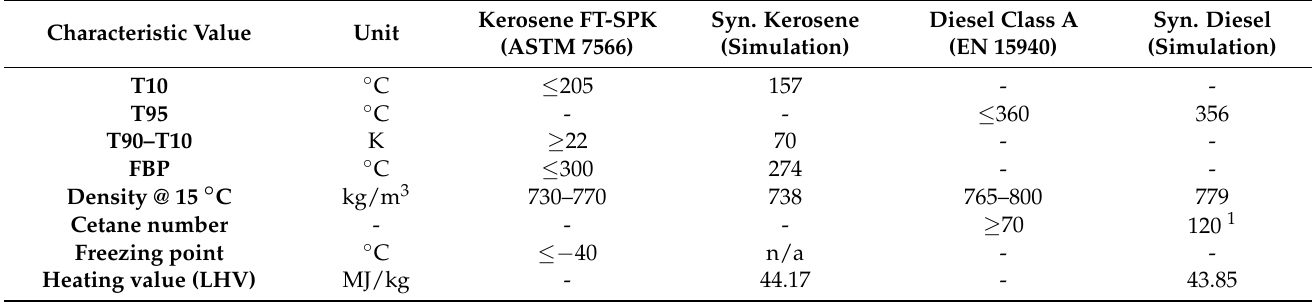
Figure 6. Excerpt from the process flow diagram: carrier steam distillation. Table 2. Characteristic values of the synthetic kerosene and diesel produced.